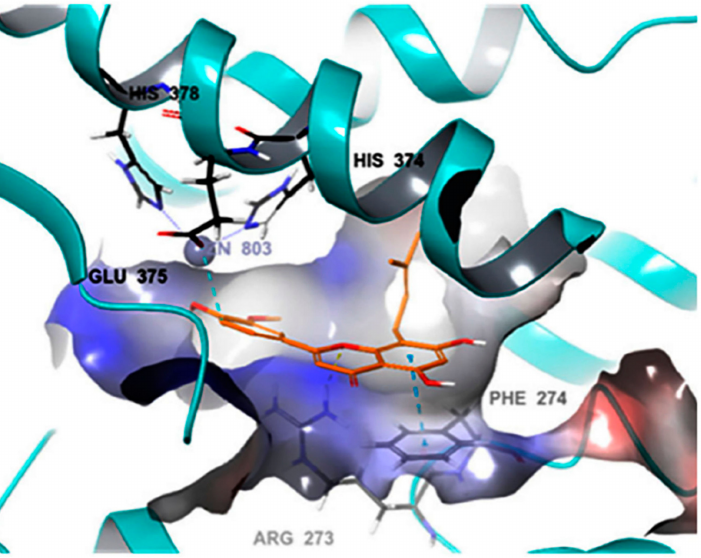
Figure 4. The main protein interactions of caflanone [39]. Reproduced with permission from Wilfred Ngwa, Potential of Flavonoid-Inspired Phytomedicines against COVID-19, published by